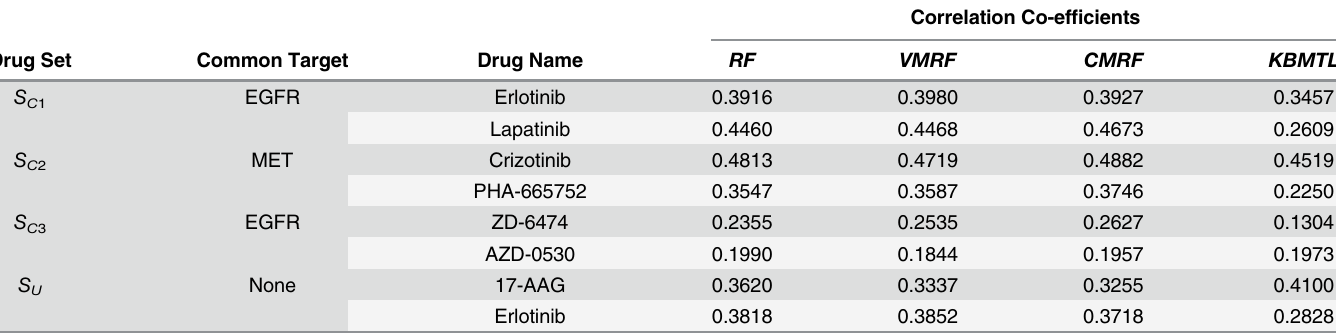
Table 5. 5 fold CV results for CCLE Dataset drug sensitivity prediction for four drug sets in the form of correlation coefficients for RF , VMRF , CMRF and KBMTL .